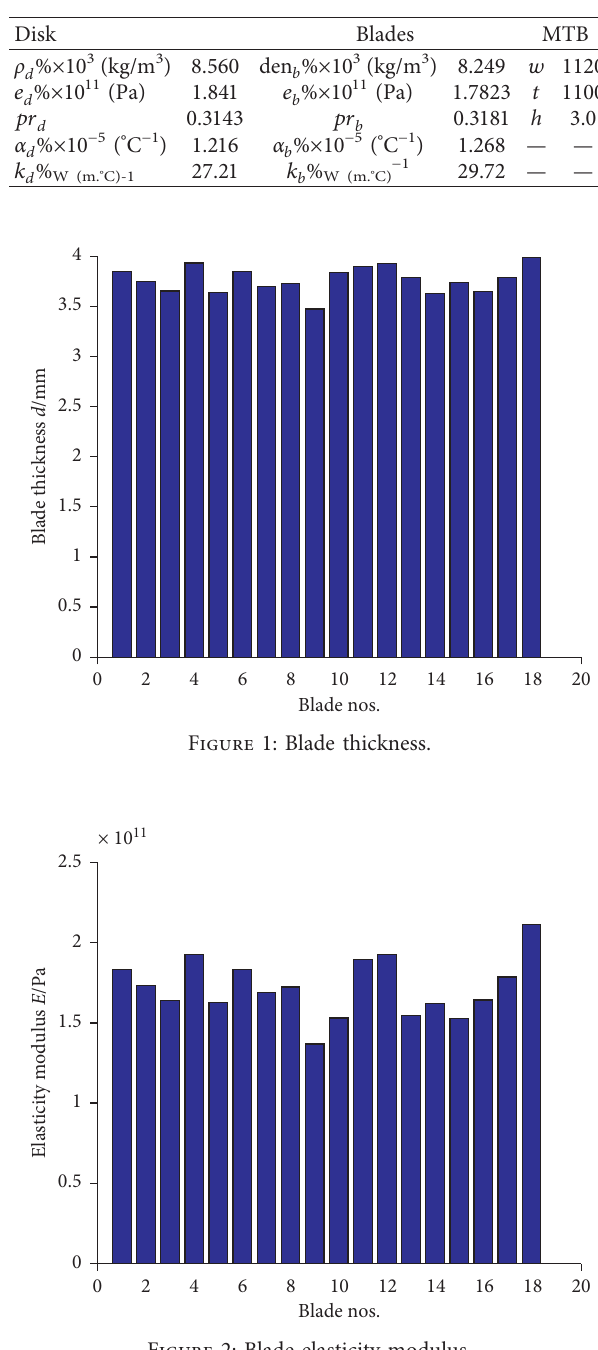
Figure 2: Blade elasticity